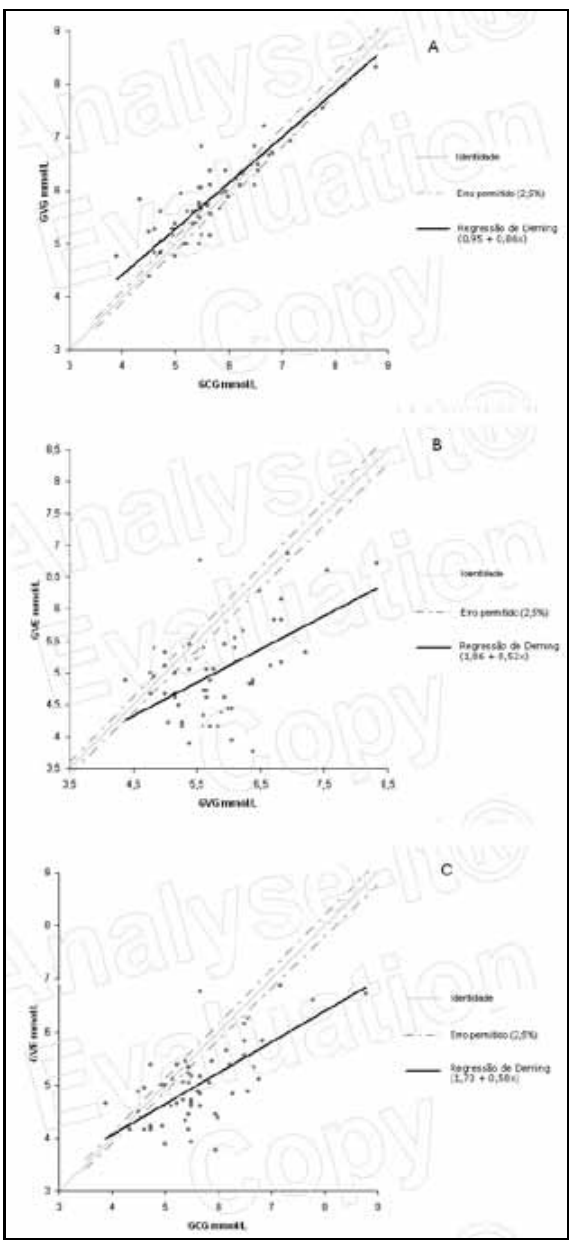
GCG e da GVG; B: entre a GVG e GVE; C: GCG e a GVE GCG: glicemia capilar determinada pelo glicosímetro; GVG: glicemia venosa determinada pelo glicosímetro; GVE: glicemia venosa determinada em plasma pelo método